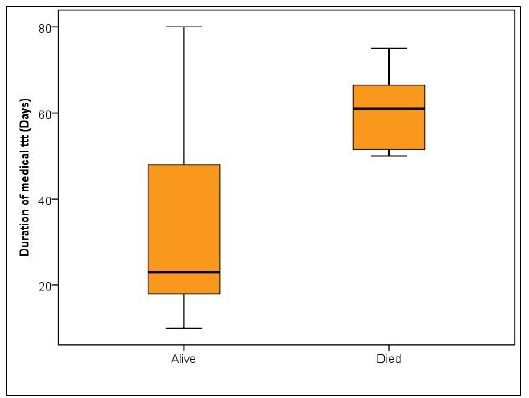
Figure 5: Error bar chart showing the relation between mortality and the duration of medical treatment during NICU admission.